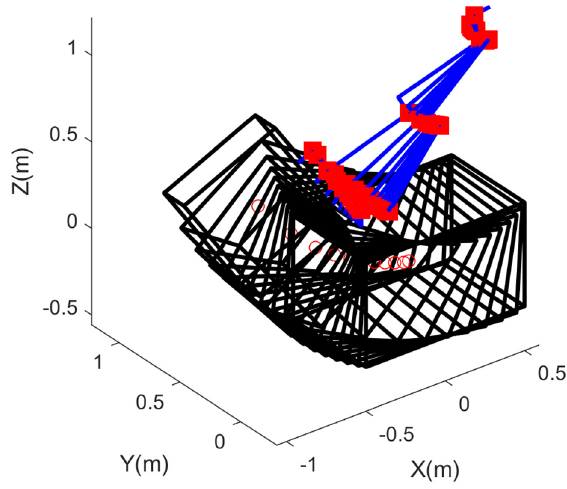
Figure 12. The configuration optimization process without considering the risk assessment model.